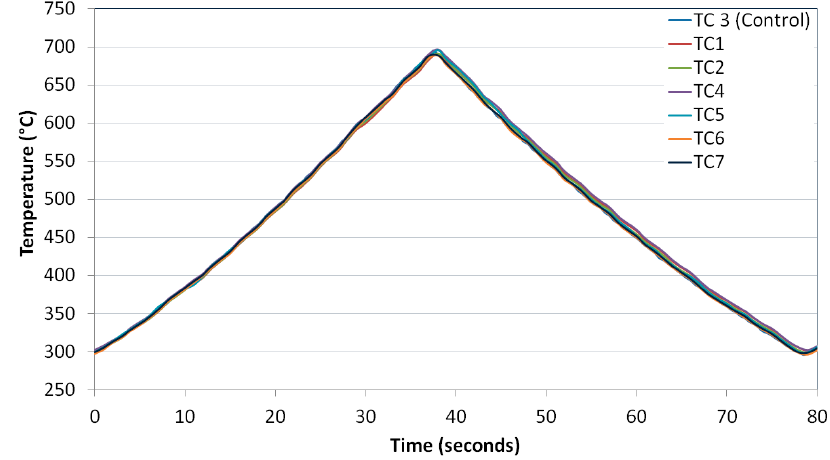
Figure 4. Thermocouple responses during the 80 s cycle.